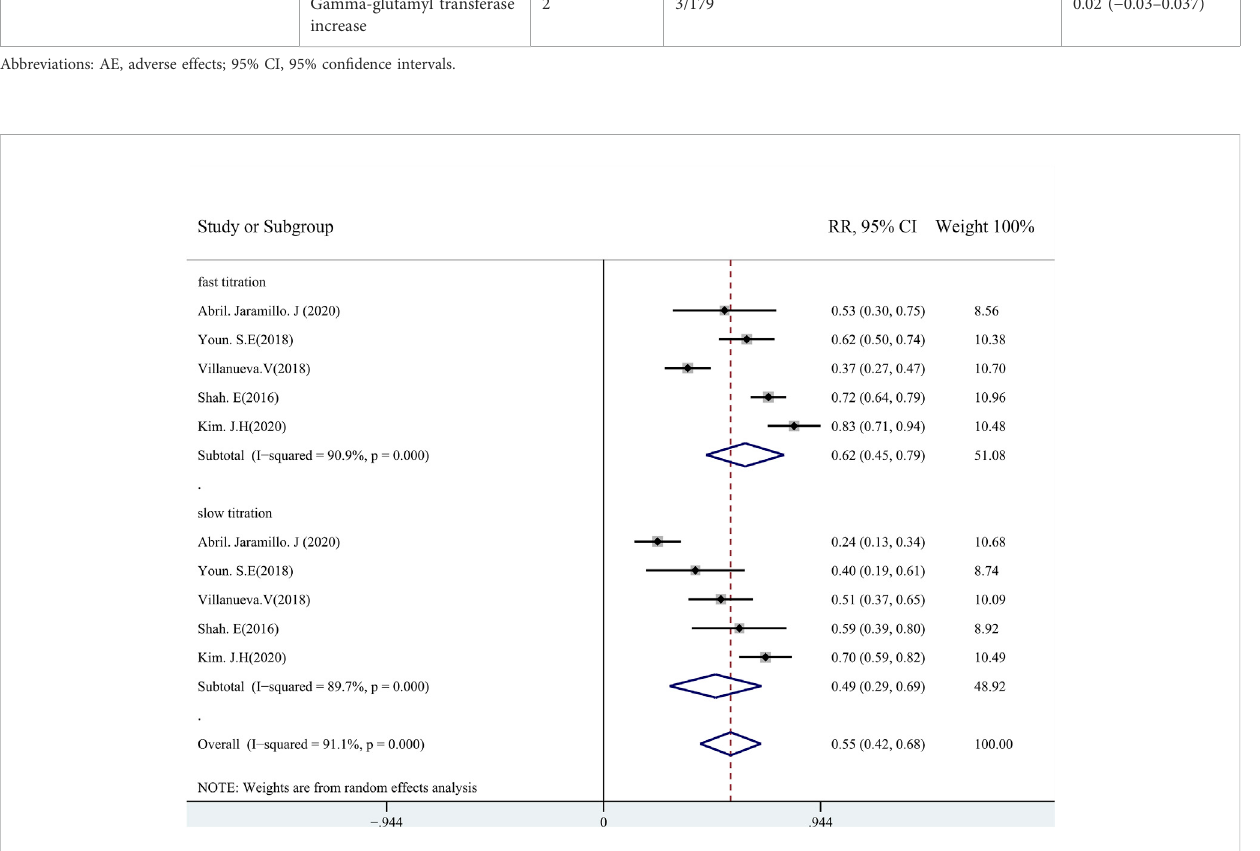
FIGURE 10 Withdrawal rate due to adverse events (rapid vs . slow dose